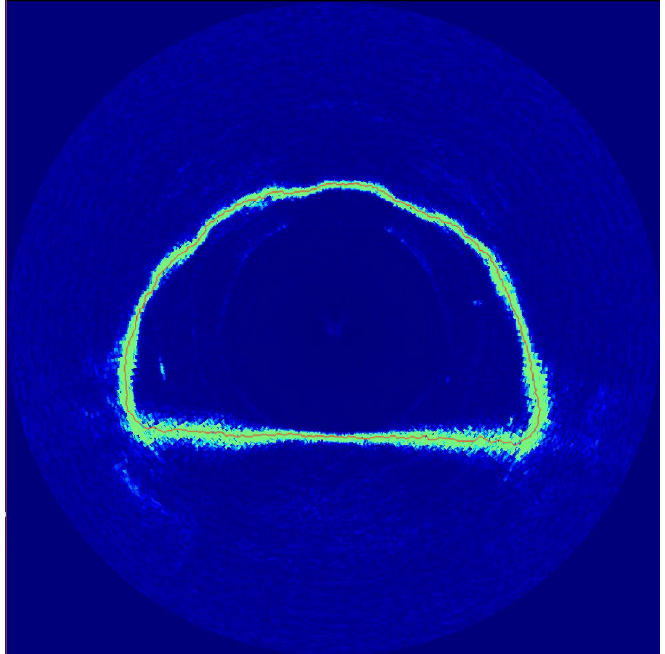
Figure 16. Cross-section of the tunnel and the red thinning line which represents its skeletonization followed by